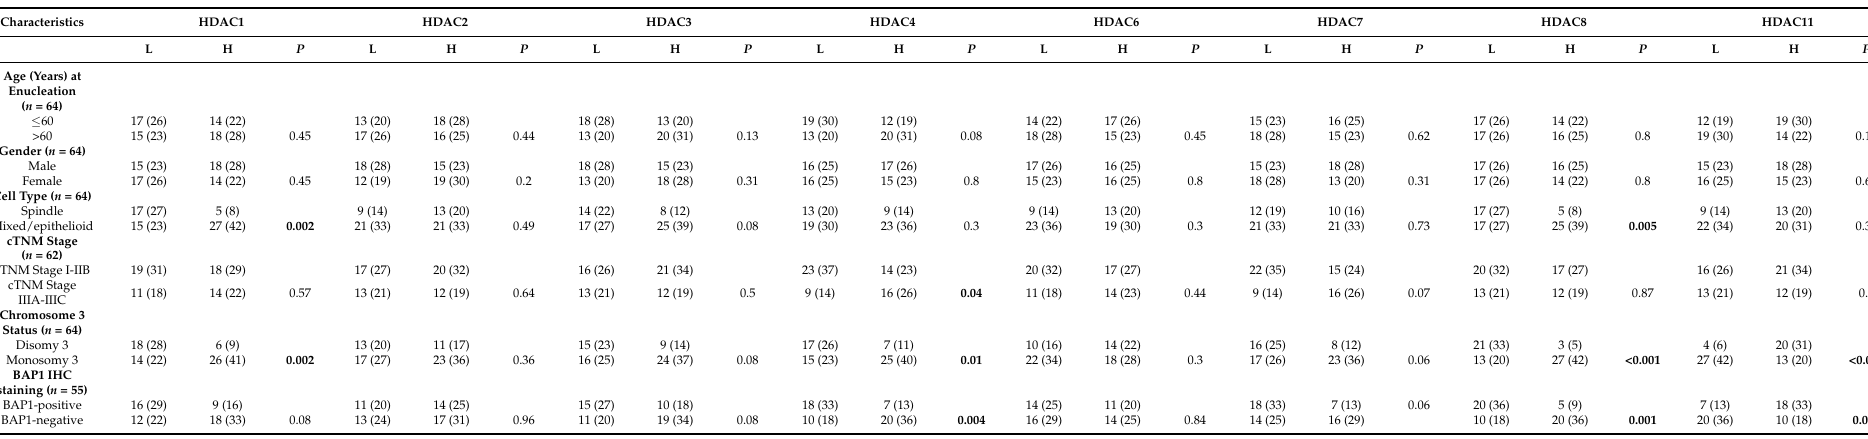
Table 2. Clinico-pathological characteristics according to low and high HDAC expression. Groups were separated according to the median into low (L) expression and high expression (H). Using Pearson’s Chi Square test, p ≤ 0.05 is considered significant (indicated in bold). Numbers in brackets represent percentages. IHC = Immunohistochemical.